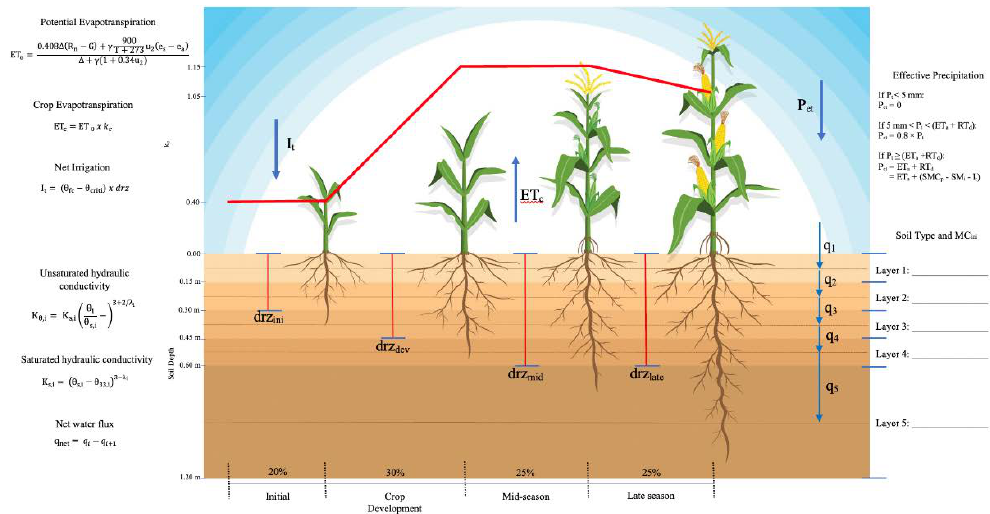
Figure 2. Conceptual model of the program.